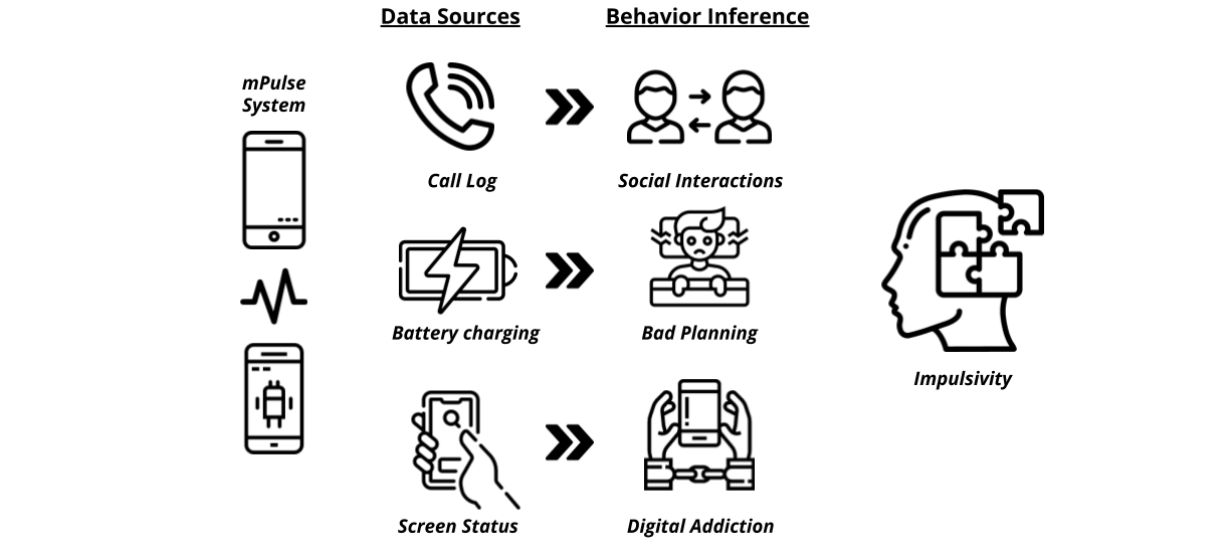
Figure 1. Conceptual framework of passive sensor data and inferred